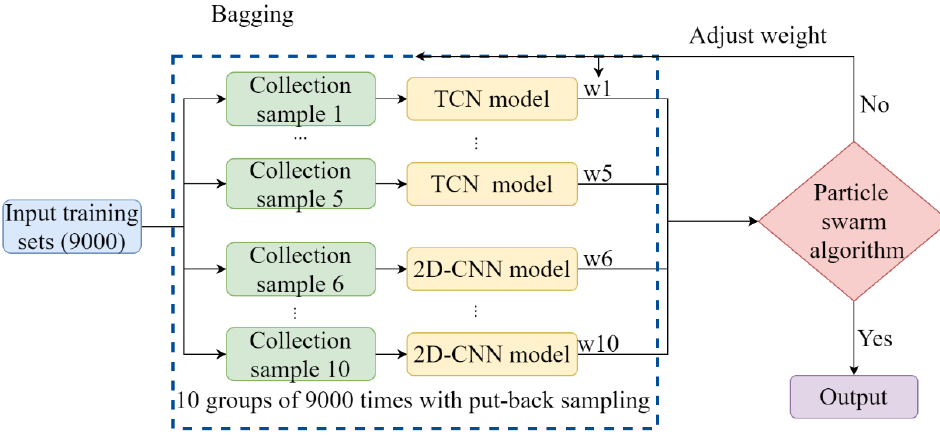
Figure 6. Flow chart of bagging method fusion model with particle swarm optimization.